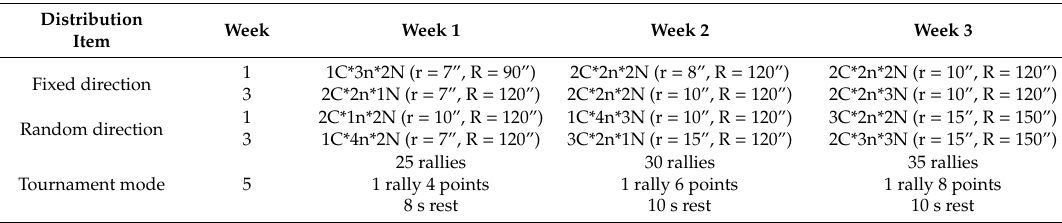
Table 1. Training program and